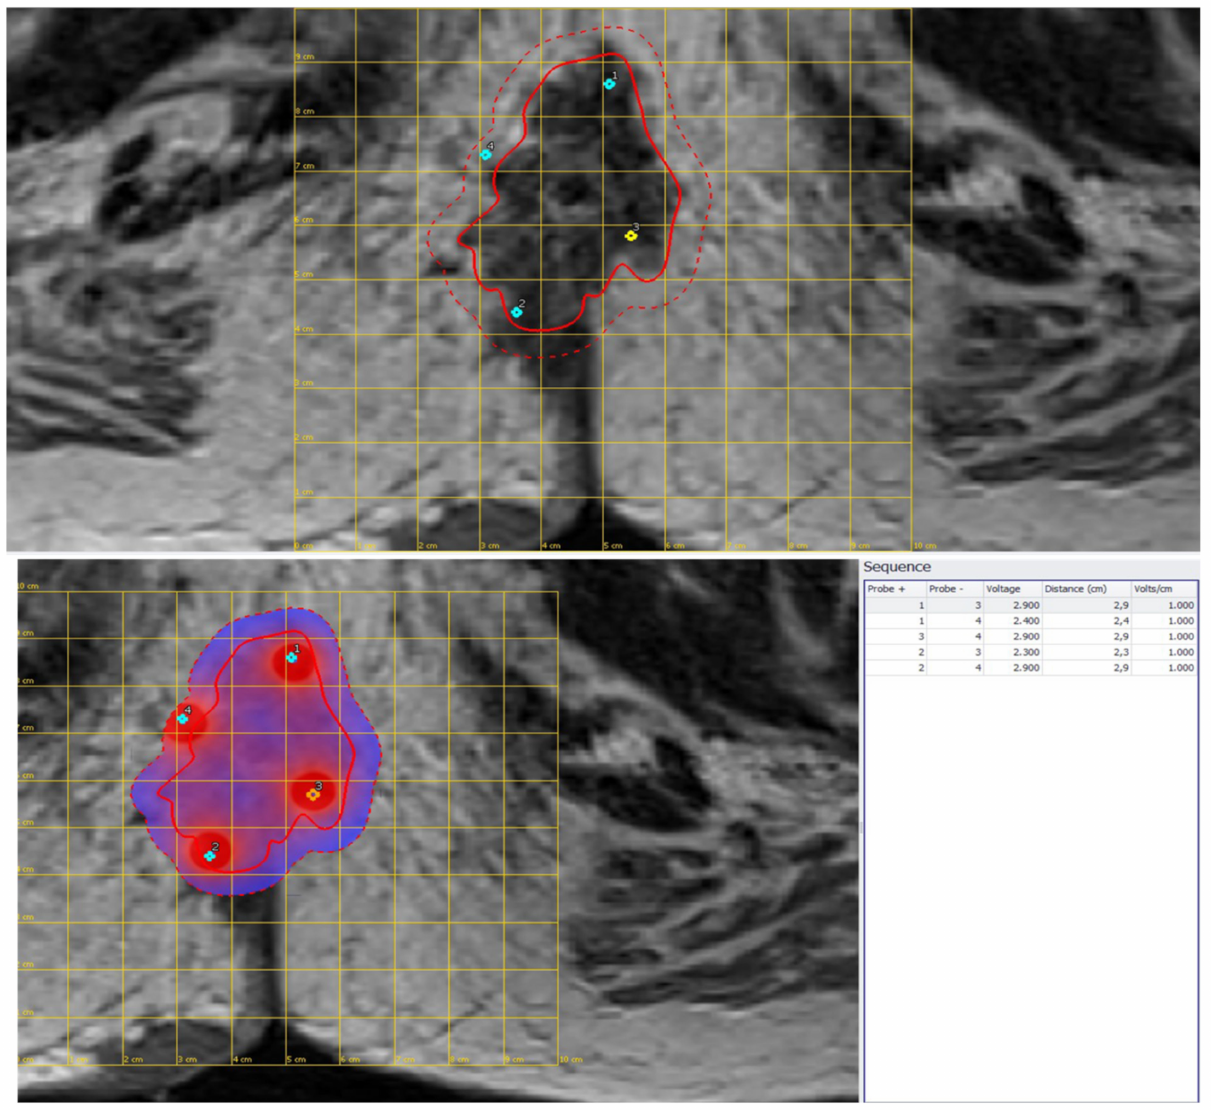
Figure 3. Preoperative planning of third LARC case effected using MR